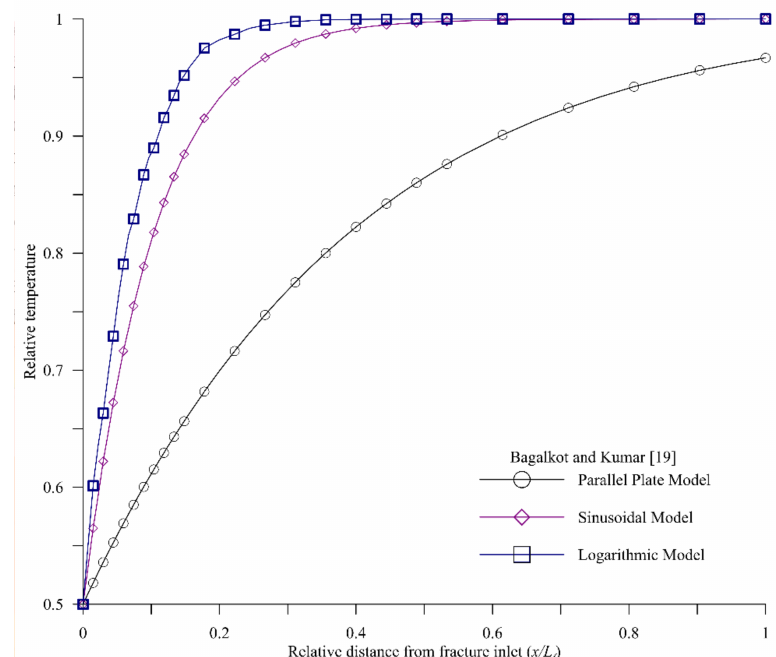
Figure 1. Spatial distribution of thermal fronts in the fracture for different types of fracture aperture from the data obtained by Bagalkot and Kumar